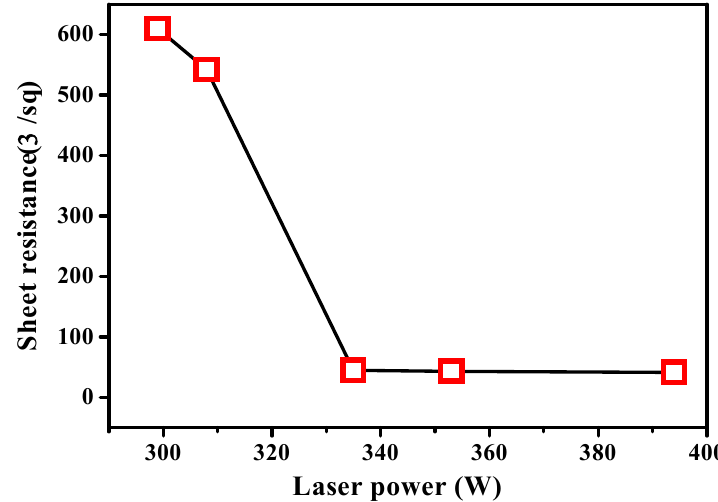
Figure 2. Sheet resistances of the samples annealed at different laser powers.